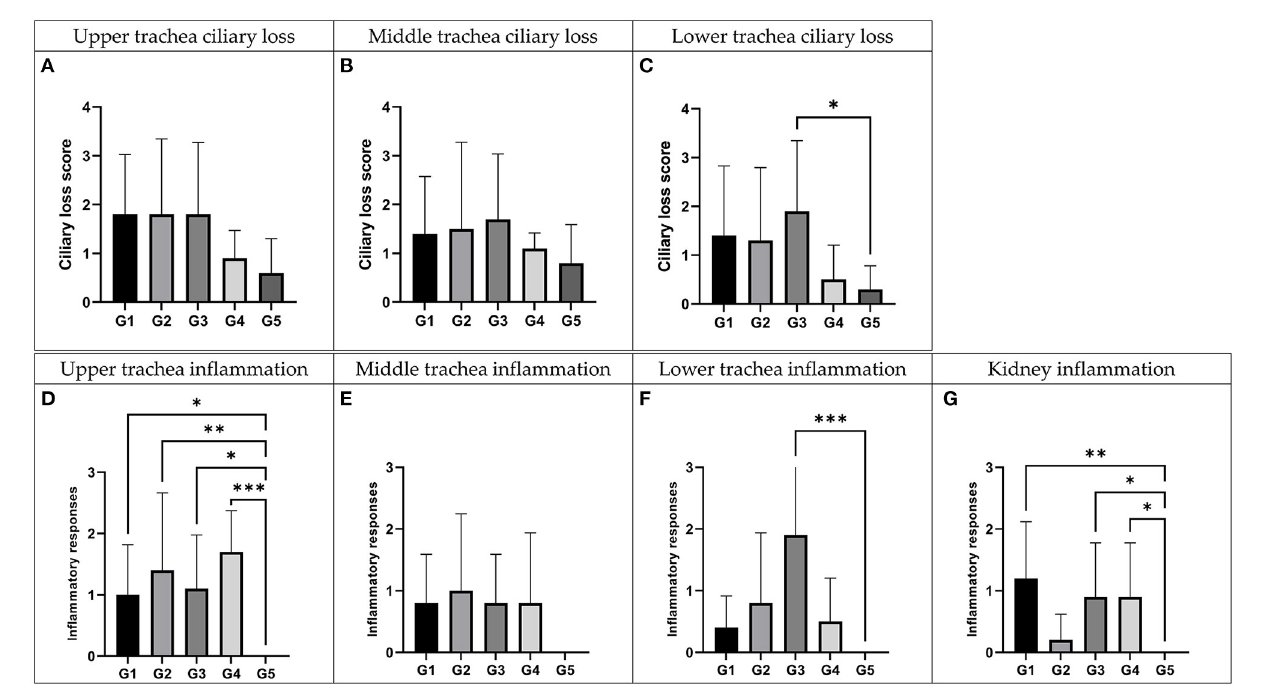
FIGURE5 Histopathologic examination of recombinant strains and their parent strains. Trachea and kidney samples were collected at 5 days post-inoculation. G1: K40/09 challenged group, G2: IBV/Korea/48/2020 challenged group, G3: IBV/Korea/289/2019 challenged group, G4: IBV/Korea/163/2021 challenged and G5: negative control group. (A–C) Ciliary damages were compared with negative control. (D–G) Inflammation responses were estimated comparing with negative control. * P < 0.05, ** P < 0.01, and *** P < 0.001, compared to the negative control group as determined using Dunnett’s multiple comparisons test.